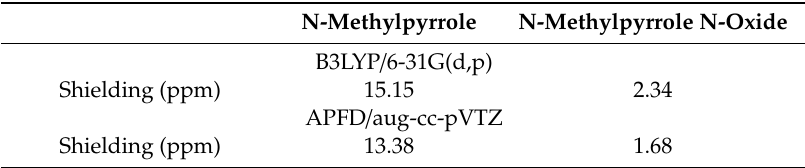
Table 7. Calculated nucleus-independent chemical shift (NICS)(0) values at two levels. A significant positive value (e.g., >5.0) connotes significant aromaticity. Significant negative values connote antiaromaticity.